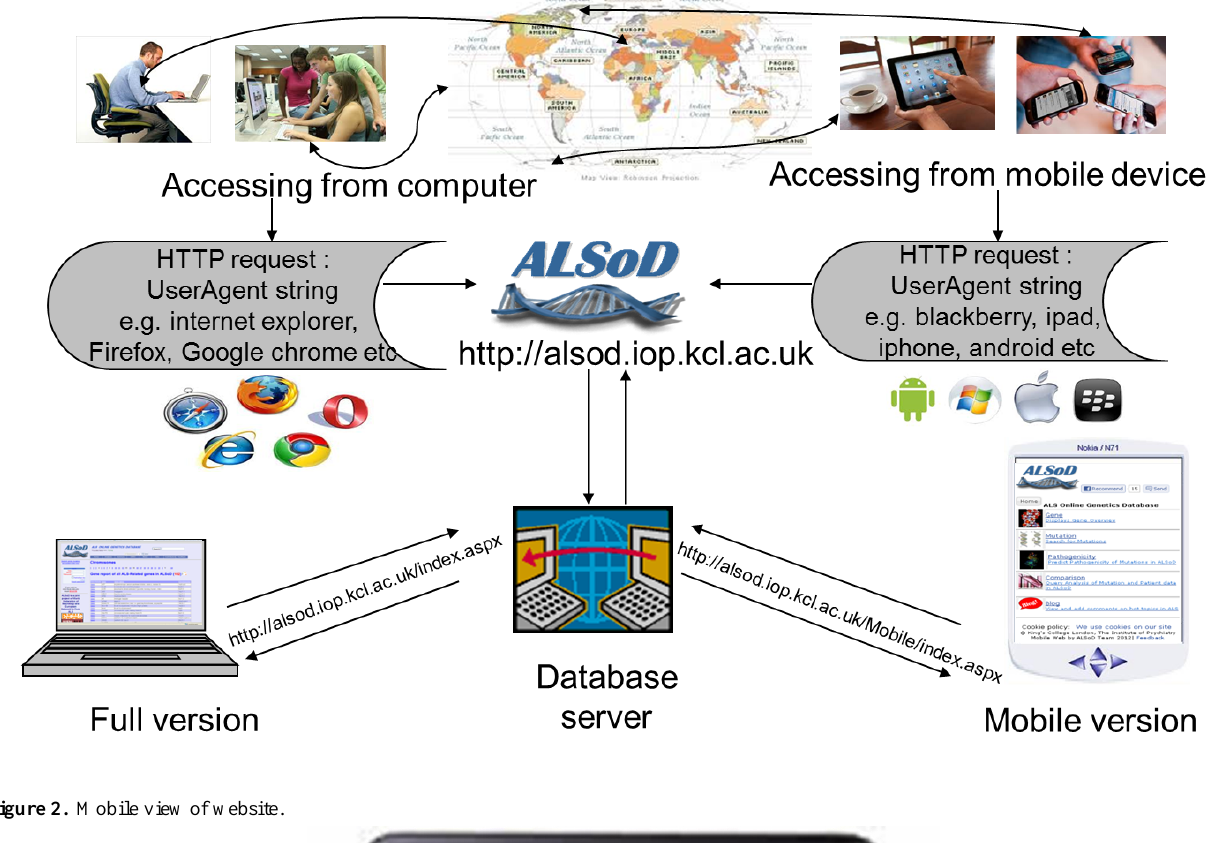
Figure 1. Overview of mobile website development.